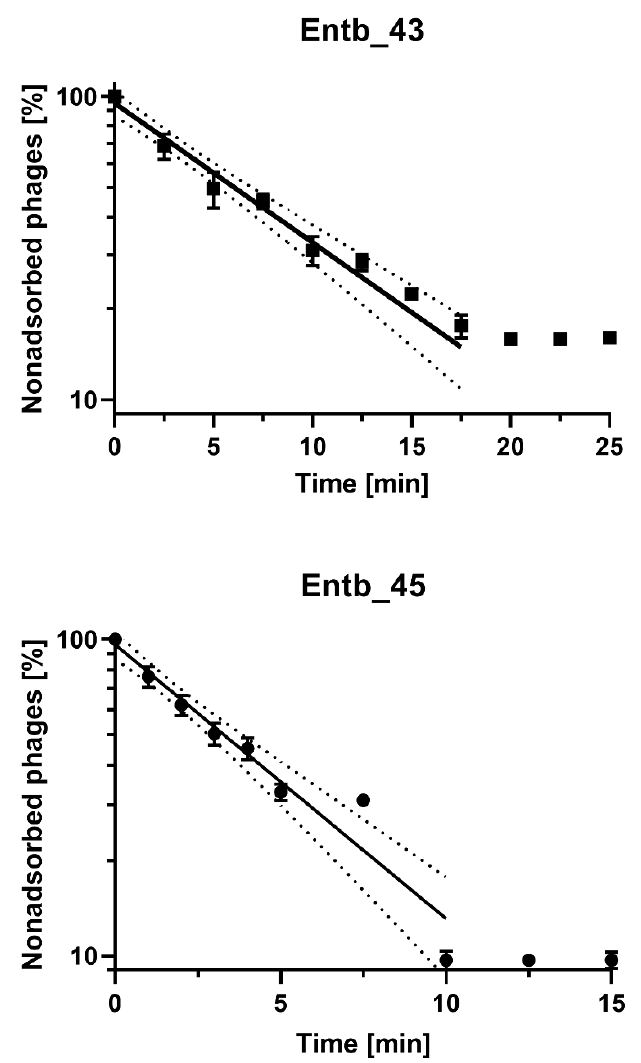
Figure 3. Kinetics of Entb_43 phage adsorption on E. cloacae 30345 and Entb_45 phage on E. cloacae 29796 at MOI = 0.1. Error bars represent the standard deviation ( ± SD) of the mean phage titers. Lines represent model used for calculation of adsorption constant; dotted line is 95% confidence interval (CI).